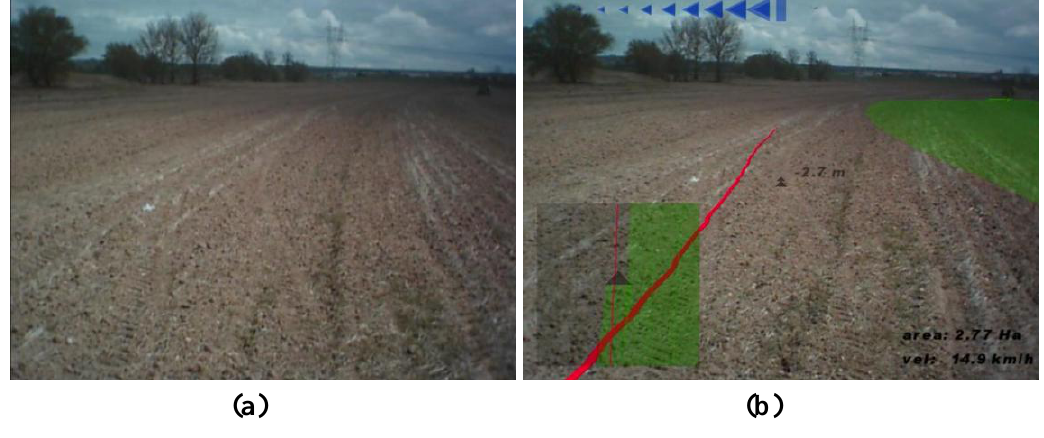
Figure 8. Another possible scene that the tractor driver sees: ( a ) without the use of the developed system or ( b ) with the use of the developed augmented reality system.